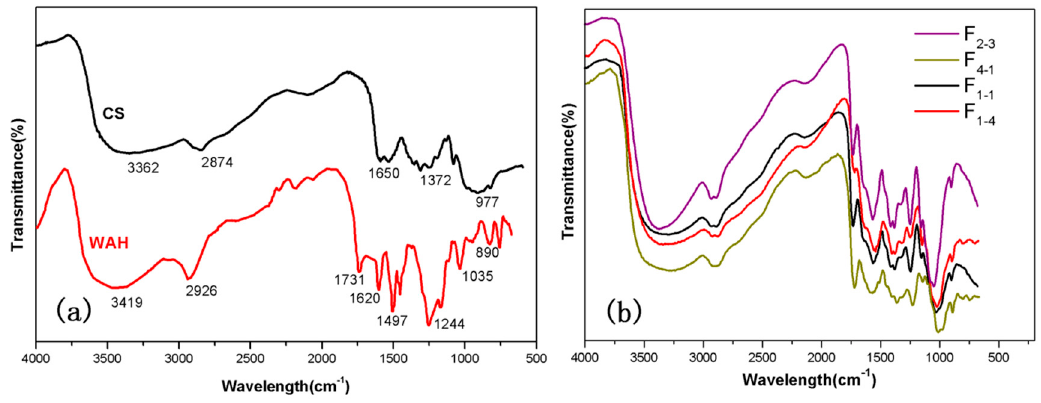
Figure 2. ( a ) Fourier transform-infrared (FT-IR) spectra of WAH and CS, ( b ) FT-IR spectra of represent composite films (F 4-1 , F 3-2 , F 1-1 , F 1-4 ).